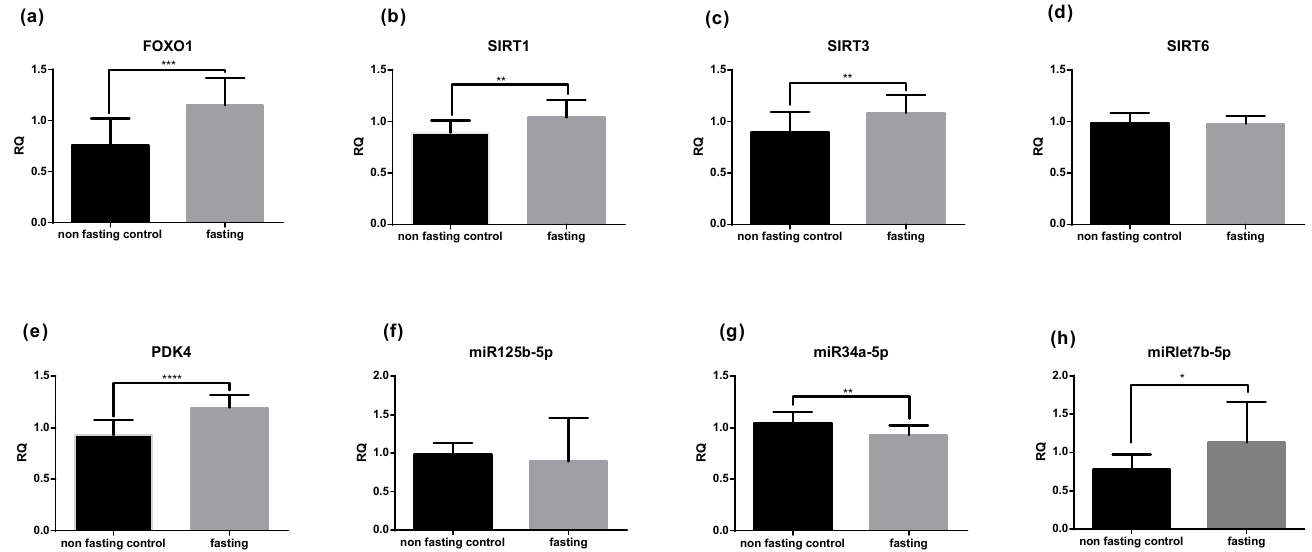
Figure 2. PF affects gene expression in blood cells. Relative quantification (RQ) after the intervention compared to the non-fasting control group of selected mRNA ( FoxO1 , SIRT1 , SIRT3 , SIRT6 and PDK4 ( a – e )) and miRNA ( miR125b-5p , miR34a-5p and miRlet7b-5p ( f – h )). The results are expressed as mean +/ − SD. Statistical significance was determined using paired t -test for parametric values and Wilcoxon test for nonparametric values.